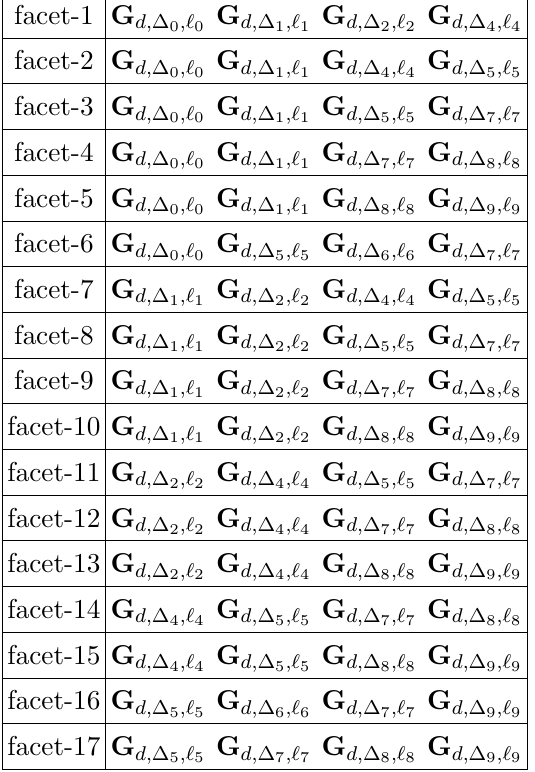
are the block vectors i ;‘ i